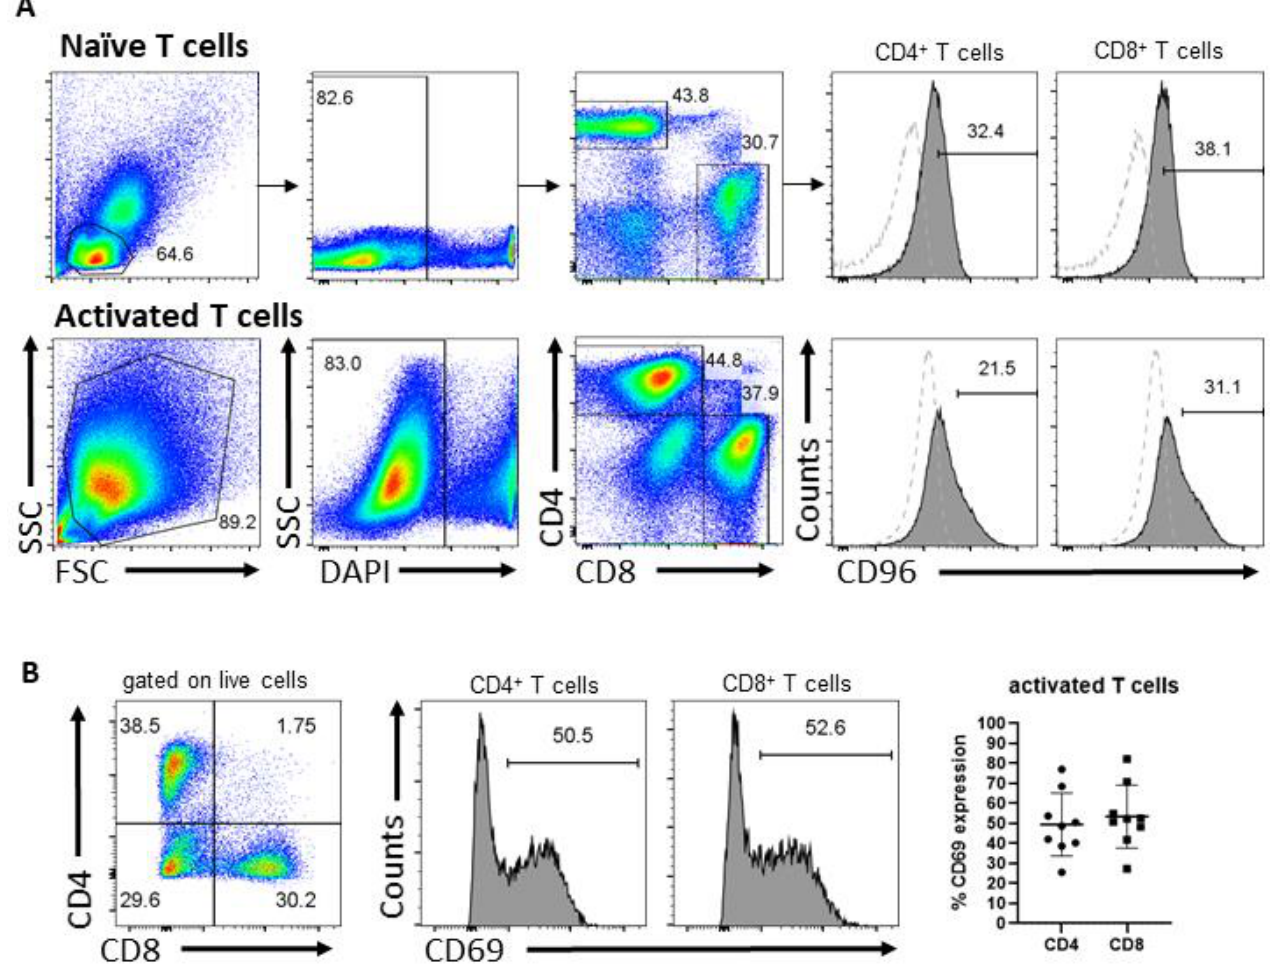
Figure 1. CD96 and CD69 expression in T cells. ( A ) Expression of CD96 in naïve CD4 + and CD8 + T cells at day 0 (top) and T cells activated by anti-CD3 and anti-CD28 Abs for 3 days (bottom), including the gating strategy. Dotted histogram represents CD96 fluorescence minus one (FMO) control cells. ( B ) Expression of CD69 in viable CD4 + and CD8 + T cells activated for 3 days as assessed by flow cytometry. Data in ( A ) are representative of 2 independent experiments. Data in ( B ) are representative of T cells from at least 4 independent donors assessed in at least 3 independent